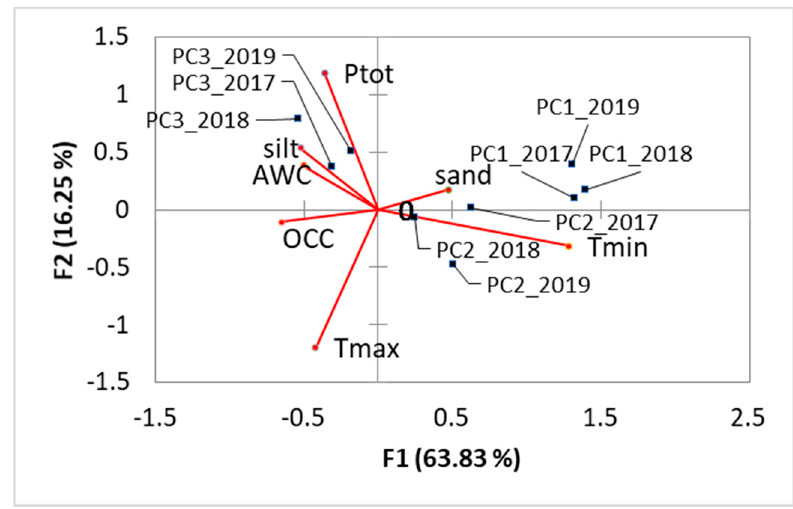
Figure 6. Correlation biplot based on Redundancy Analysis (RDA) performed in the sample points with the SOIL and CLIM variables as predictors, and the PCs for each year as response variables.